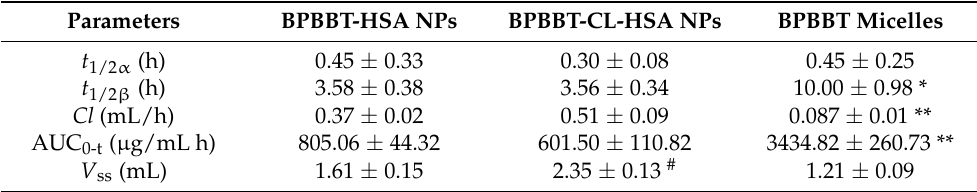
HSA NPs or BPBBT micelles (20 mg/kg of BPBBT) into the tumor-bearing mice a .